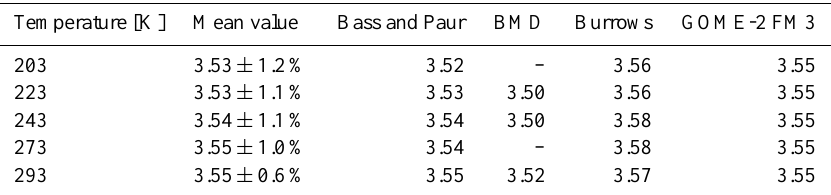
Table 3. Comparison of integrated cross sections in the Hartley and Huggins bands (245–340nm) in units of 10 − 16 cm 2 nmmolecule − 1 , the second column indicates the mean from all available literature ( Orphal,